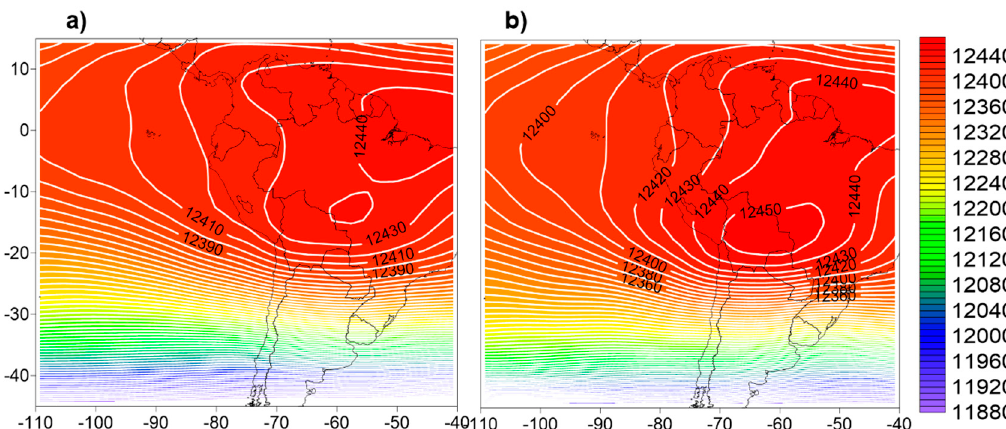
Figure 10. Average geopotential height of 200 hPa of the rainy period from 1981 to 2017 ( a ) and the 40 extreme rainfall events ( b ) considered in m.